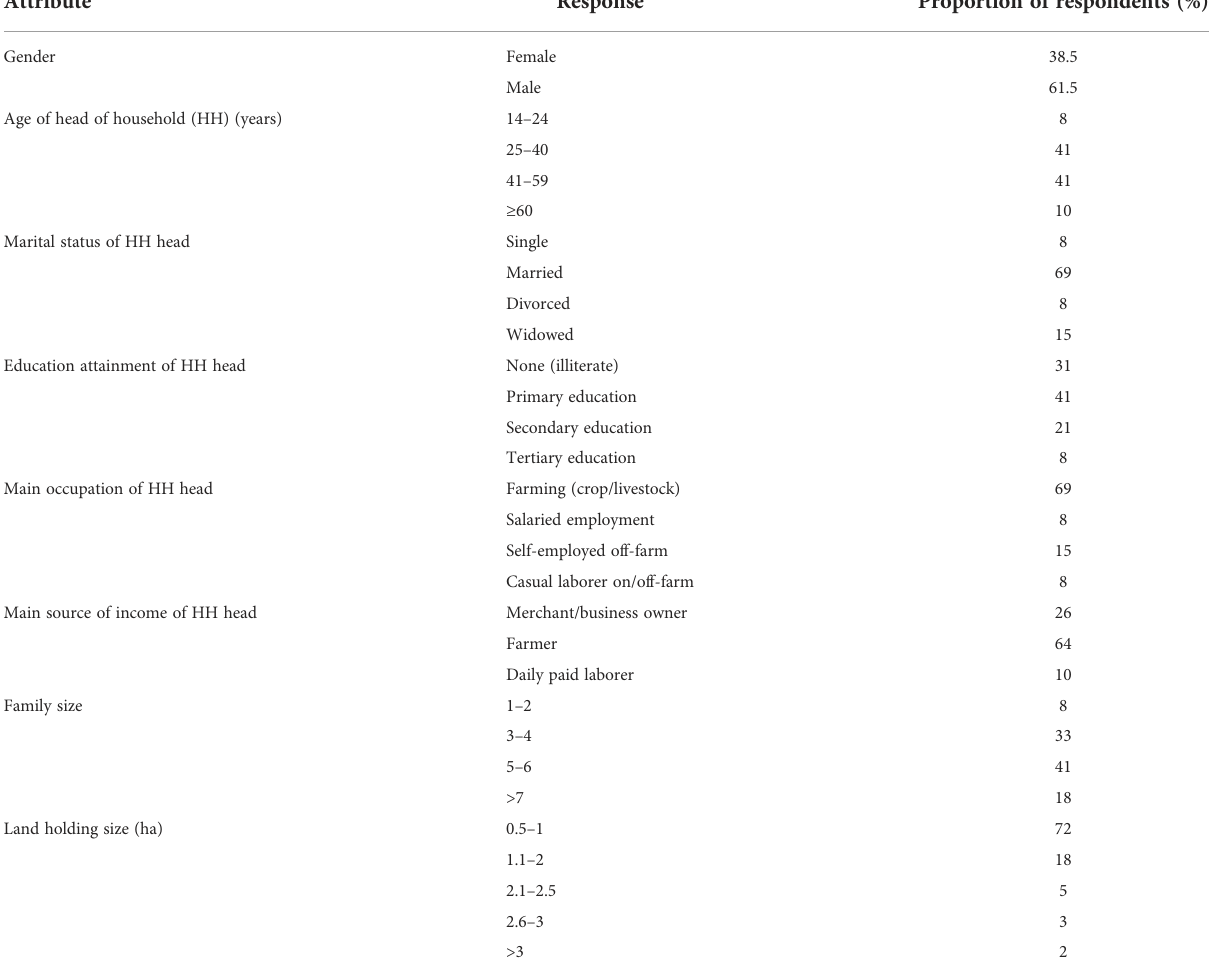
TABLE 1 Demographic pro fi les of the respondents surveyed by questionnaire (n =